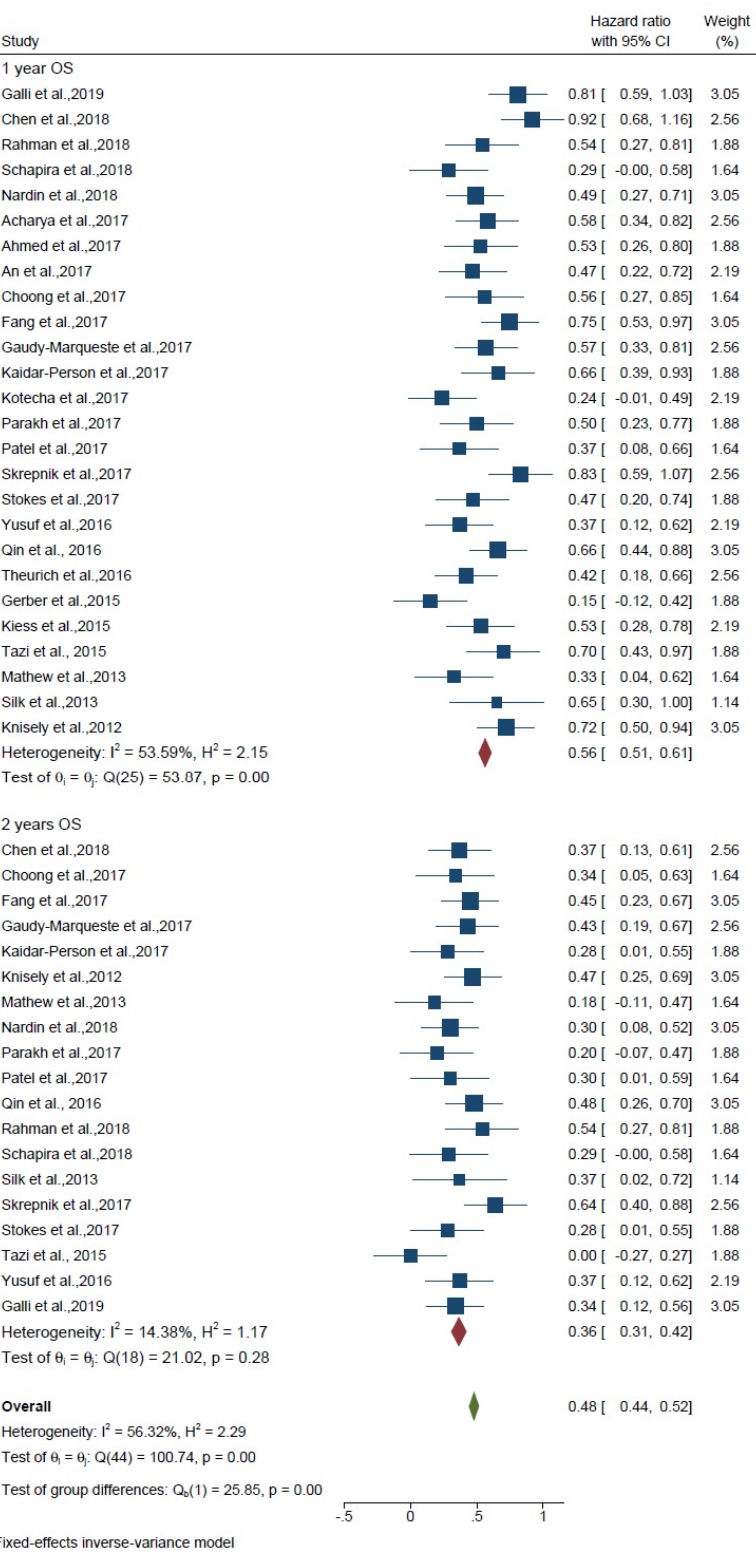
Figure 3. Forest plot shows overall survival of 1 and 2